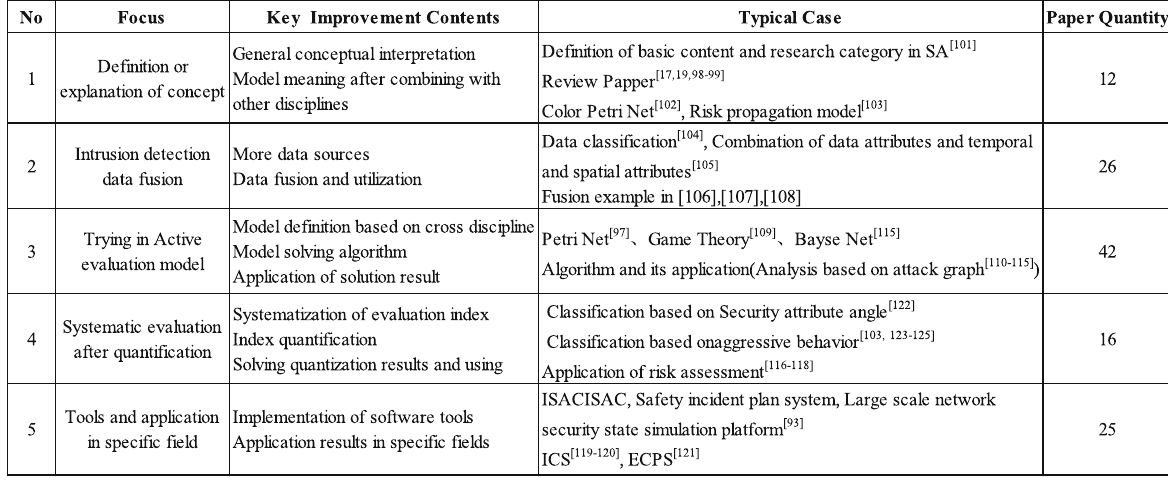
Table 4 Statistical classification of about 100 Chinese literature based on titles and